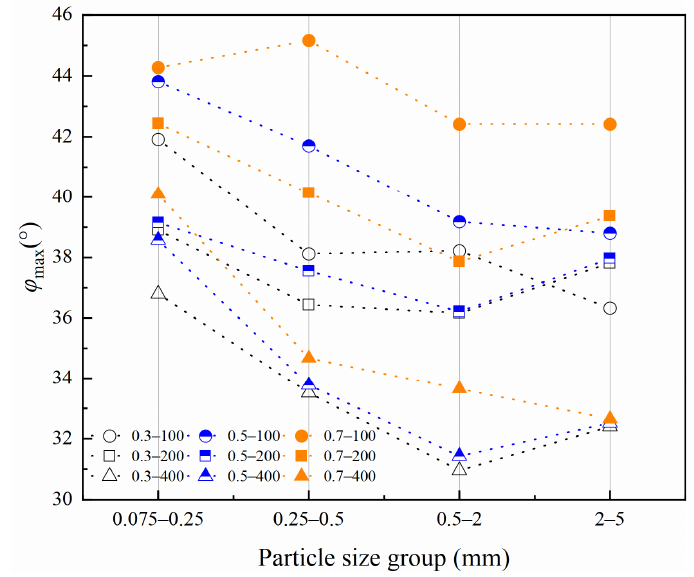
Figure 11. Peak internal friction angle of volcanic soil with different relative density ( Dr ) and confining pressure( σ 3 ) in four particle size groups.